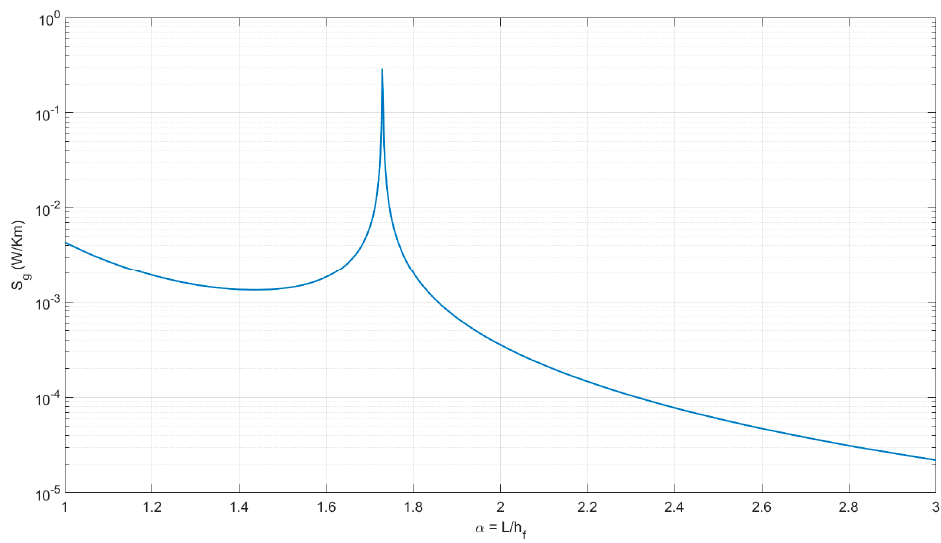
Figure 5. Total entropy generation rate versus aspect ratio for α = 3.